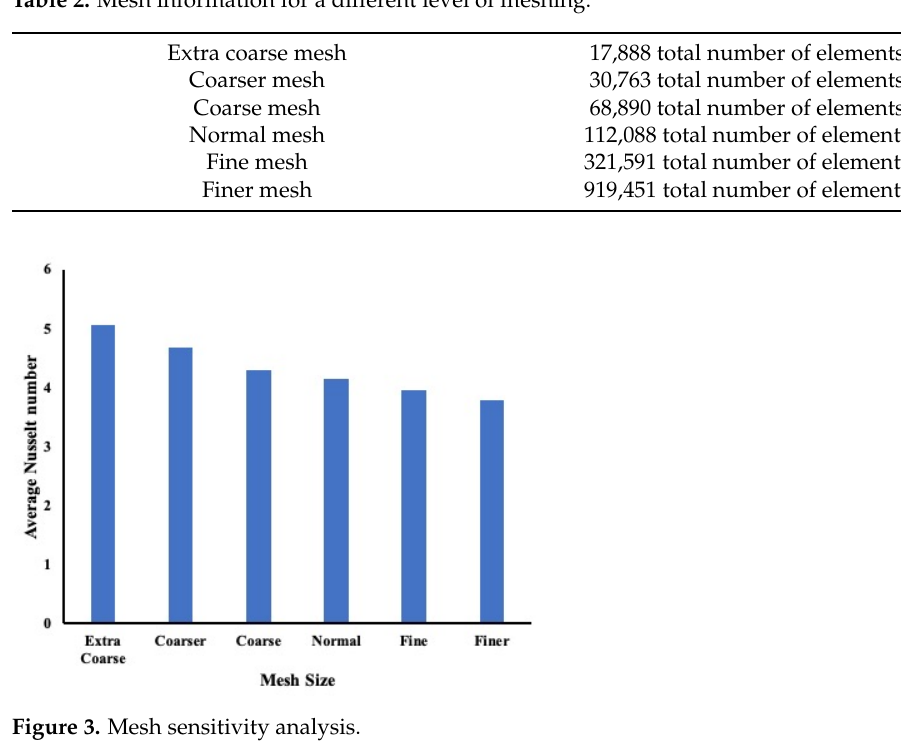
Table 2. Mesh information for a different level of meshing.